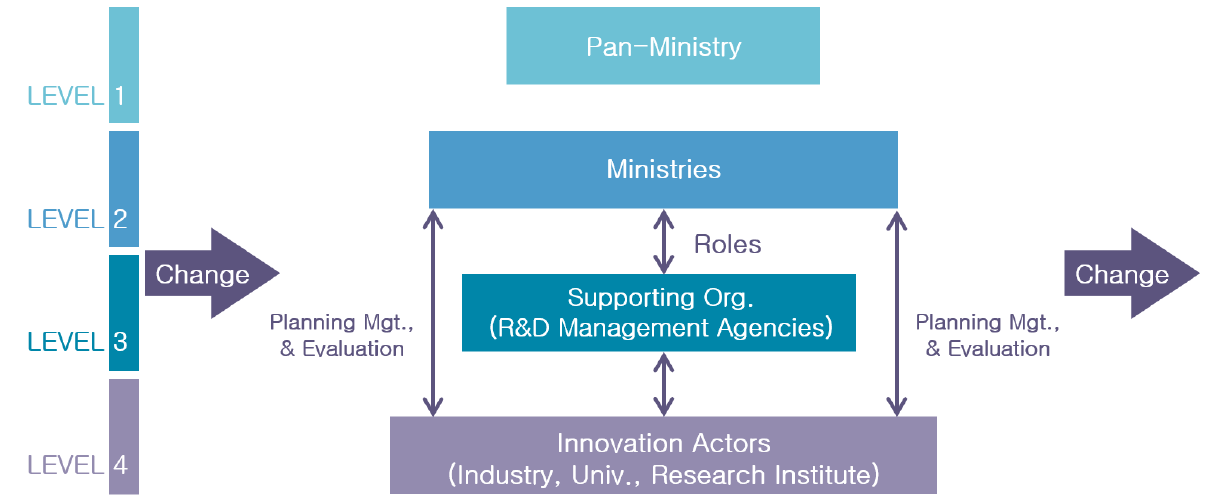
Figure 1. Mechanism of the national R&D program management in the National Innovation System. Source: The Impact of Organizational Competencies on the Performance of R&D Management Agencies in Korea. Hong et al. (2018) [5], Hwang et al. (2019) [6].